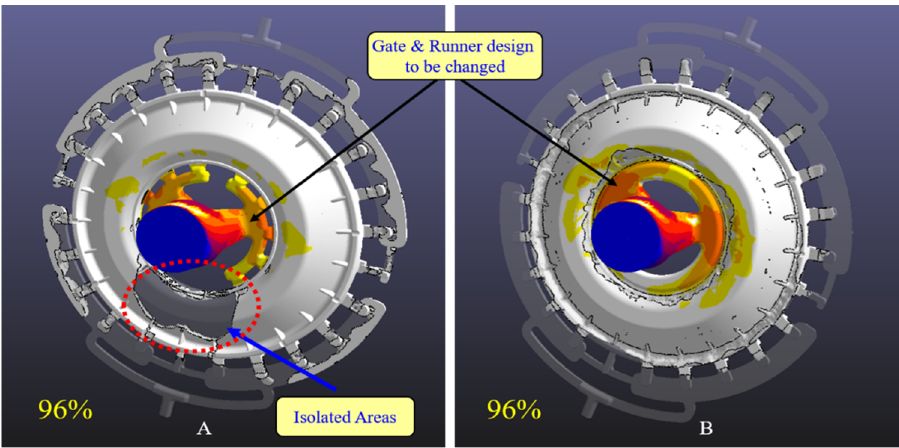
Figure 5. Simulation results of the melt flow: ( A ) 96% filling of case 1; ( B ) 96% filling of case 2.